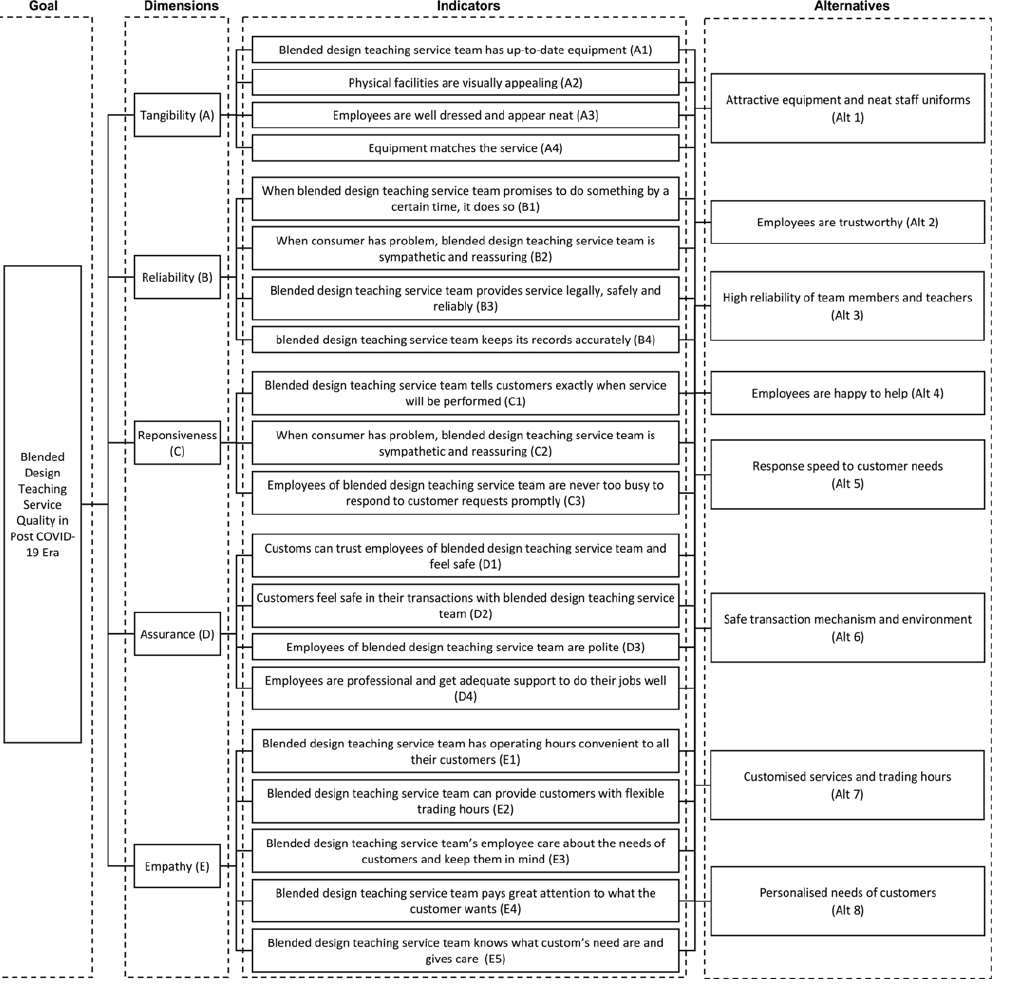
Figure 3. The evaluation structure of blended design teaching service quality.